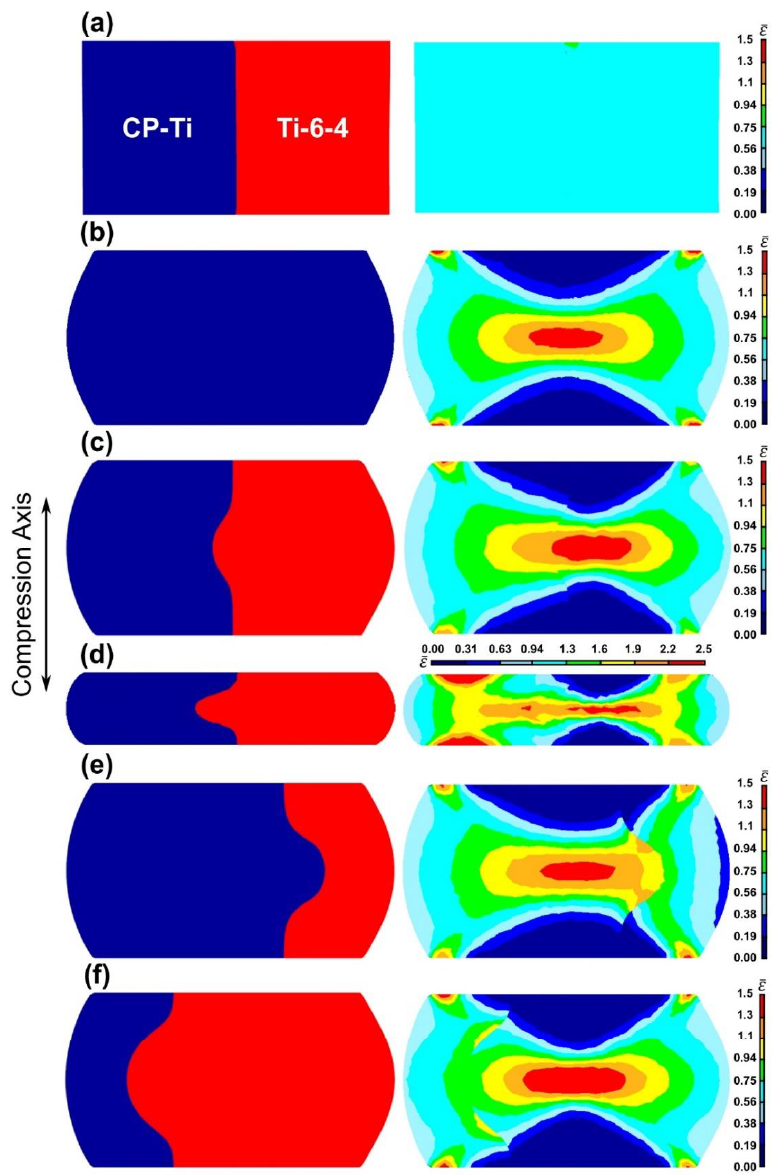
Figure 8. Uni-axial compression FE simulations of FAST-DB samples, showing the bond interface location with corresponding strain distribution. Simulation conditions are a strain rate of 1 s − 1 , 850 °C, and a progressive friction factor of 0.2-0.5-0.9. ( a ) 1:1 alloy distribution with zero friction; ( b ) single alloy with friction; ( c ) 1:1 alloy distribution with friction; ( d ) 1:1 alloy distribution with friction at quarter deformation height; ( e ) dominant CP-Ti with friction; and ( f ) dominant Ti-6-4 with friction. When the alloy volume fraction is 1:1 with zero friction the geometry remains